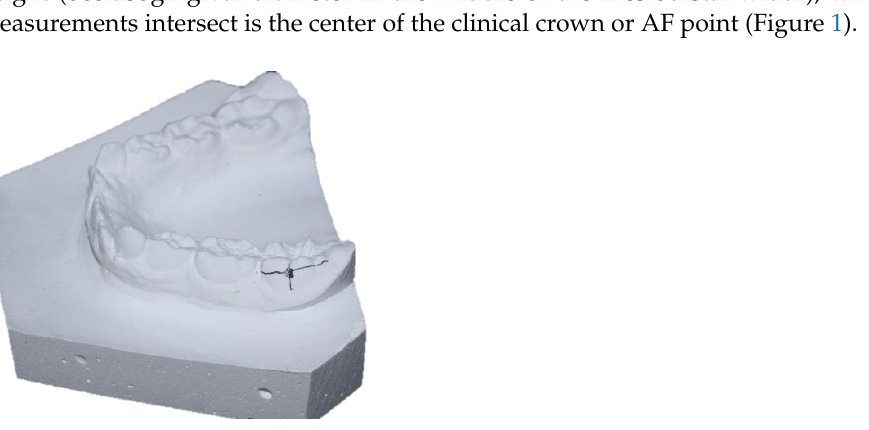
Figure 1. Location of the Axial Face (AF) points. Figure obtained by Dr. Ramon Herrero R. Subsequently, the Wala Ridge points were recorded: for this purpose, the projection of the AF points was traced by a tangent to the vestibular side of the molar and perpendicular to the occlusal plane in an occlusal view of the model. This projection will reach the maximum bone contour line, where the Wala Ridge point will be found (Figure 2).